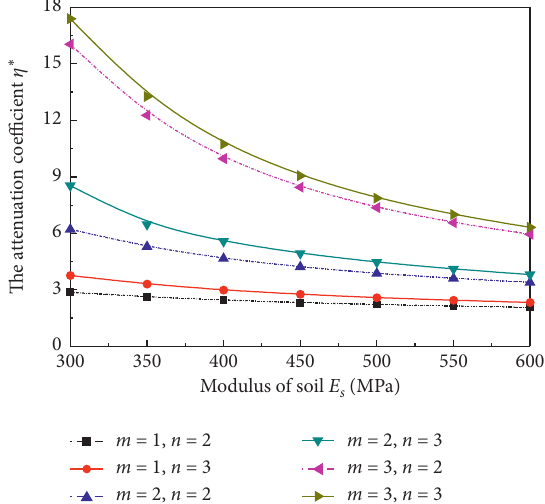
Figure 11: Relationship between attenuation and the modulus of soil, where η � 1.0 × 10 6 Pa ·